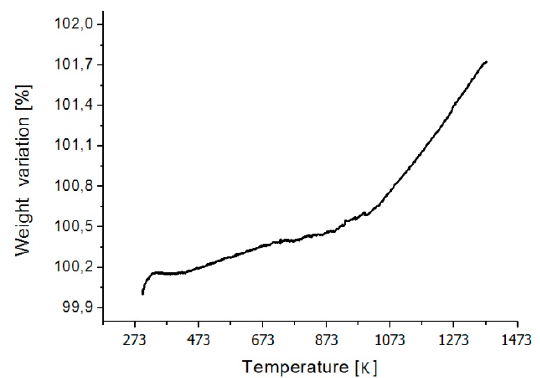
Figure 3. TG/DTA (thermogravimetry coupled with differential thermal analysis) scan of Cu 10 Zr 7 intermetallic, showing the rate of oxide formation upon heating.